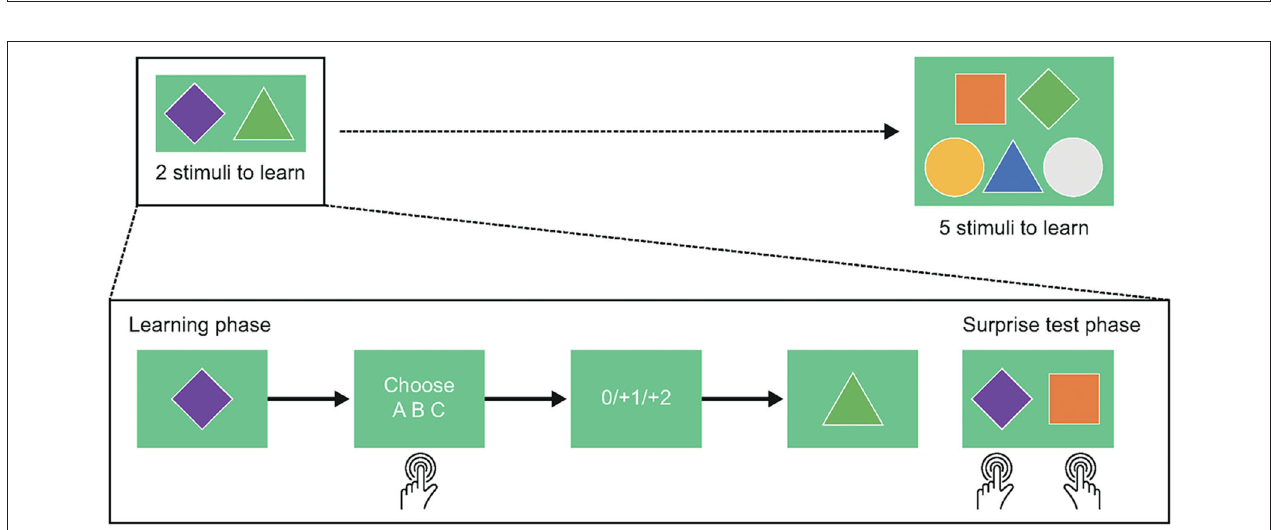
FIGURE 2 | The Doors task. In the Doors task, participants will complete 4 practice trials and 60 assessment trials, for a total task duration of approximately 15min. EEG, electroencephalography; FRN, feedback-related negativity.